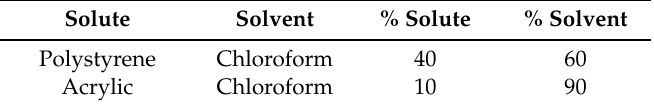
Table 2. Percentage of polymers acrylic and polystyrene to be used in chloroform.